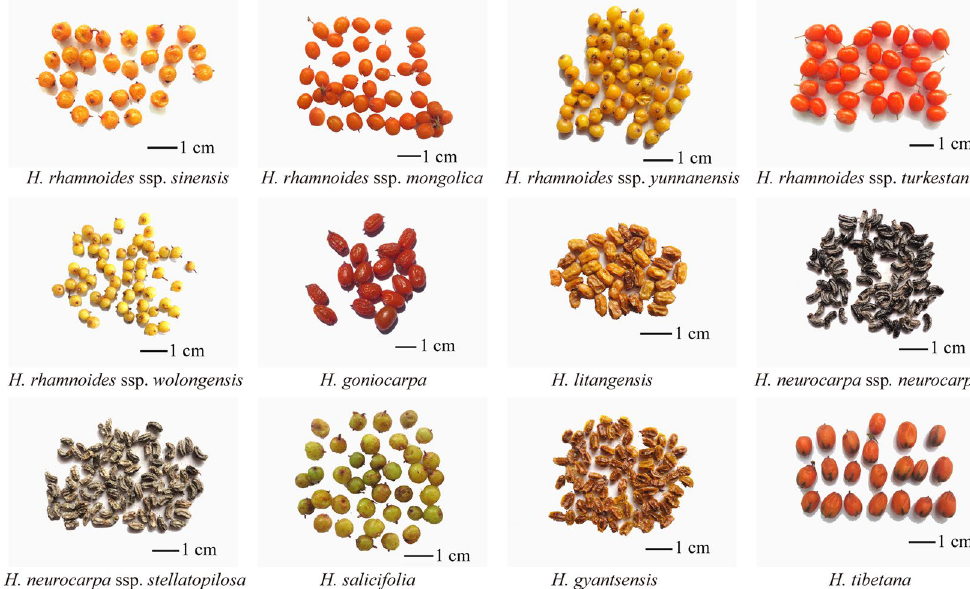
Figure 5. Berry samples from seven species and seven subspecies of Hippophaë collected from